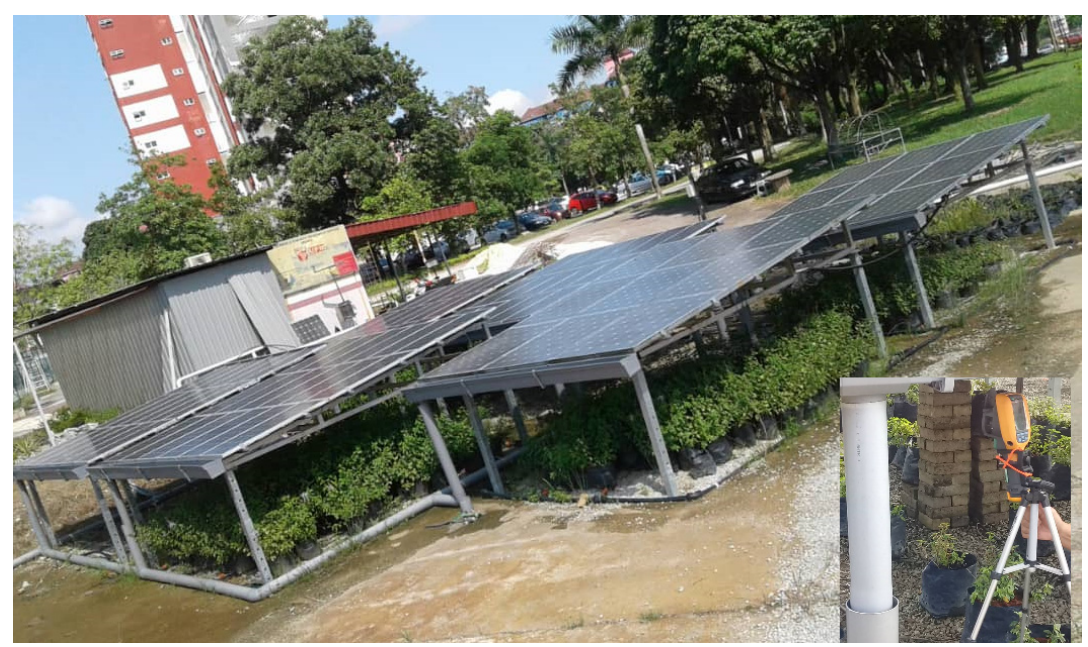
Figure 5. Agrivoltaic system with a Fluke thermal imager on a tripod for video recording.